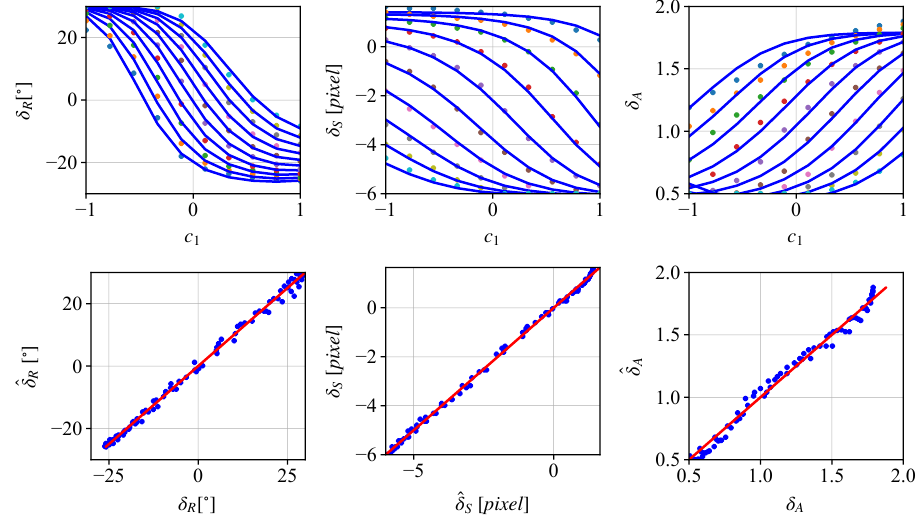
Figure 10. The comparison of three estimated properties ˆ δ R , ˆ δ S , and ˆ δ A , using (30), and the measured ones, δ R , δ S , and δ A , using (19). The relation with δ R (dots) and two latent codes, c 1 and c 2 (different colors denote different values of c 2 ) ( top-left ). The ˆ δ R is shown with blue lines. They are close to the δ R . The comparison of δ R and ˆ δ R ( top-right ). The results of δ S and ˆ δ S are shown in the middle-right and middle-left images, respectively. The results of δ A and ˆ δ A are shown in the bottom-right and bottom-left images,